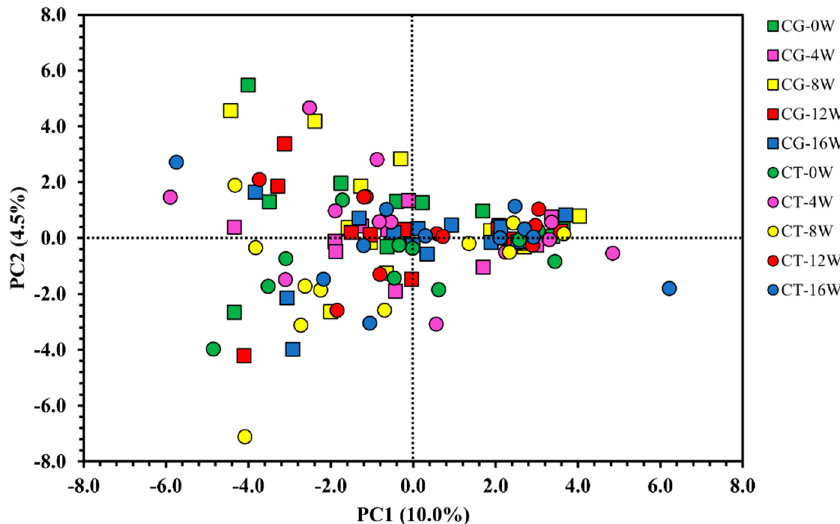
Figure 1. Principal component analysis (PCA). Control Group (CG) is represented by the square ( ☐ ) and the Combined Training (CT) is represented by the circle ( ◯ ). Colours vary according to the time of data collection; 0W = green: pre-training; 4W = pink: 4 weeks; 8W = yellow: 8 weeks; 12W = red: 12 weeks; 16W = blue: 16 weeks. The present model used data for all 66 metabolites detected.